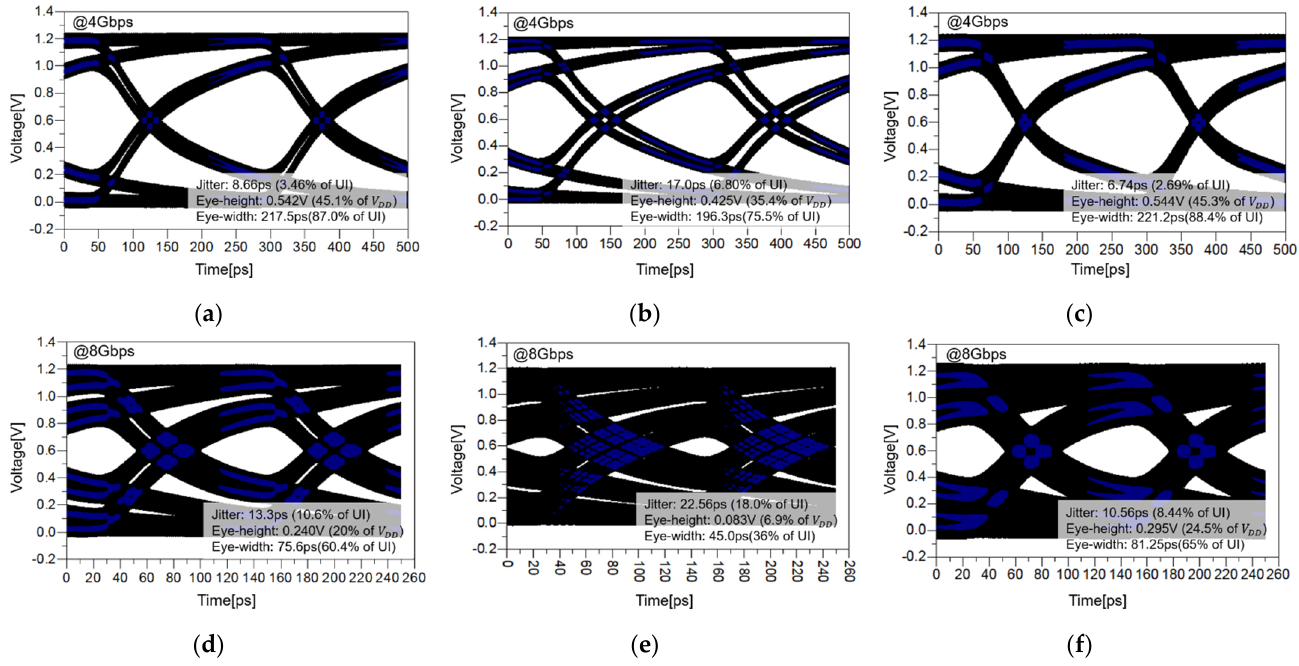
Figure 15. Eye-diagram of the conventional micro-strip line, strip line, and the proposed structure: ( a ) micro-strip line at 4 Gbps, ( b ) strip line at 4 Gbps, ( c ) proposed structure at 4 Gbps, ( d ) micro-strip line at 8 Gbps, ( e ) strip line at 8 Gbps, and ( f ) proposed structure at 8 Gbps. At 4 Gbps, the proposed channel structure can improve eye width, eye height, and